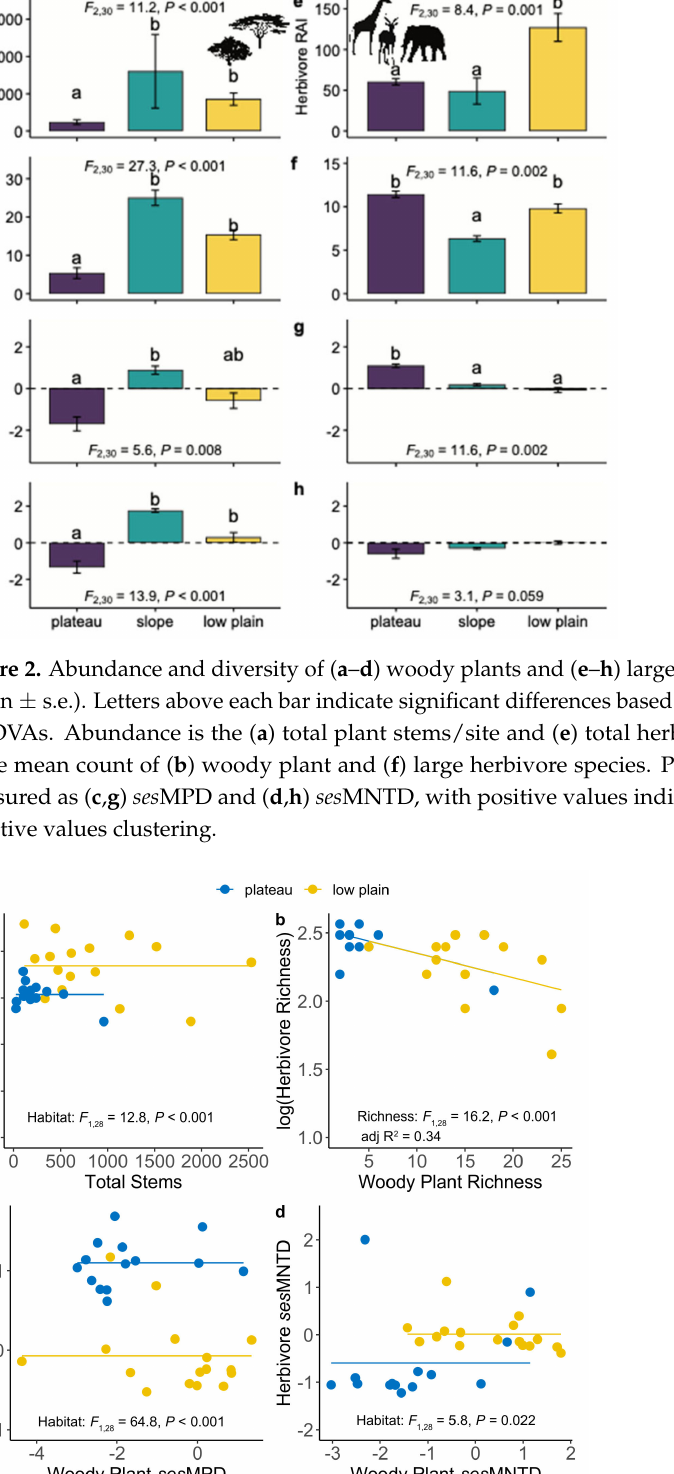
Figure 3. Relationships between herbivore ( a ) abundance, ( b ) taxonomic richness, ( c ) ses MPD, and ( d ) ses MNTD with corresponding measures for woody plants. For each pair of metrics, we constructed initial linear models with predictors including the woody-plant variable, habitat, and the plant variable × habitat interaction. We simplified models based on the subset of statistically significant variables. We report adjusted R 2 for the model that included a significant correlation ( b ). Horizontal lines show significant differences between habitats ( a , c , d ). Colors show habitat